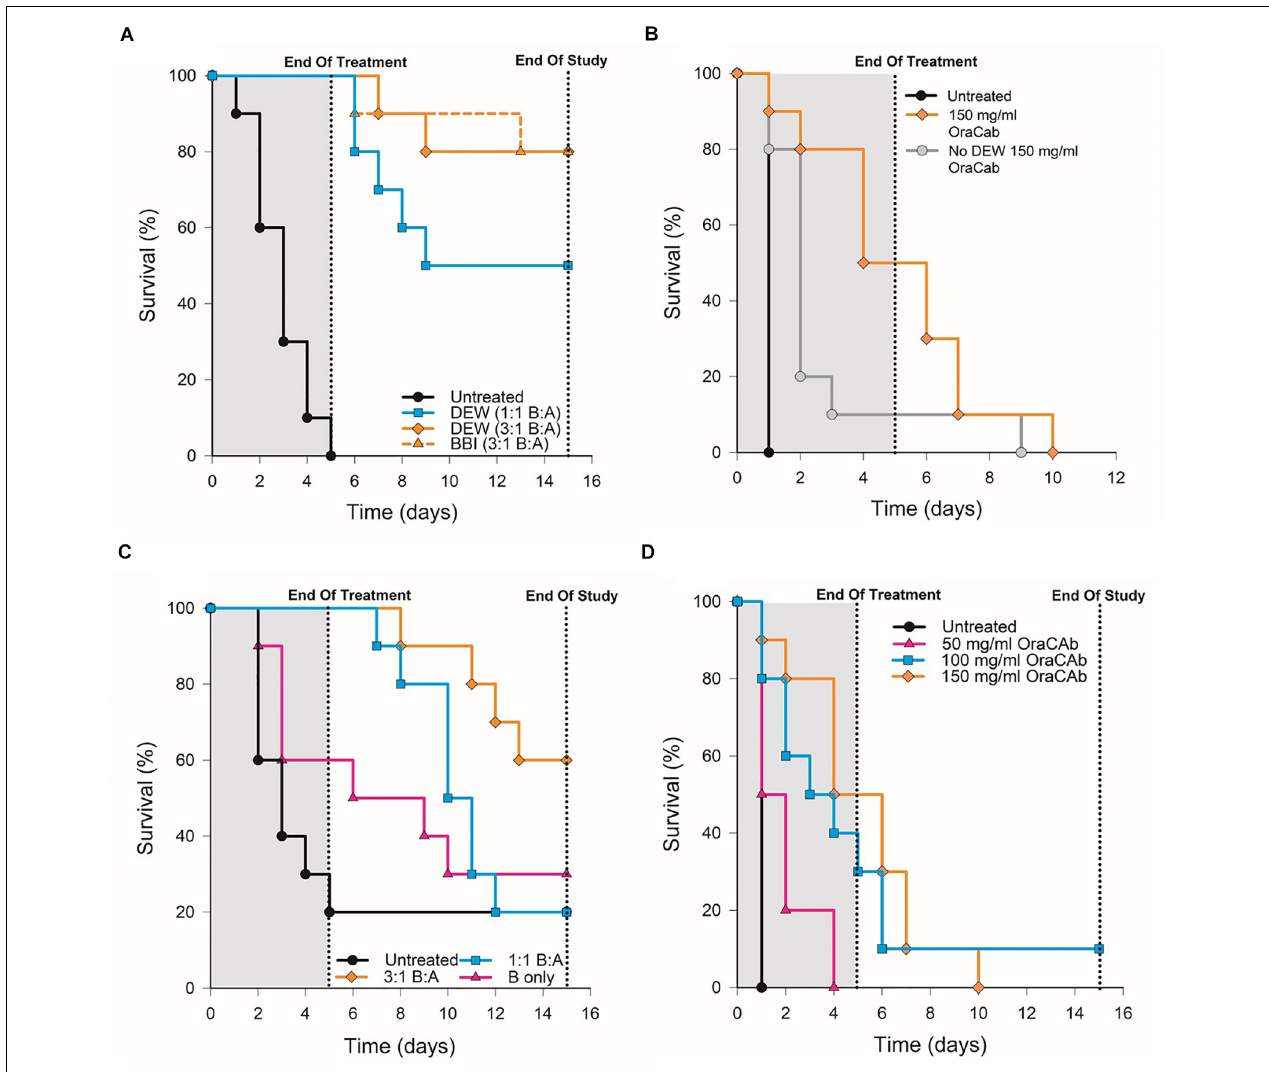
FIGURE 5 | Survival rates of hamsters after C. difficile challenge. Hamsters were challenged with C. difficile spores via the oral route on day 0, placed on one of the oral therapeutic regimes until the end of day 4 and monitored until day 15. An untreated control group, receiving challenge only, was included for each experiment. (A) Groups were treated with OraCAb containing different ratios of anti-TxB4: anti-TxA4 antibodies with either BBI or DEW as trypsin inhibitors. (B) Groups were treated using OraCAb formulated with antibody concentration of 150 mg/ml at a 3:1 anti-TxB4: anti-TxA4 ratio in the presence or absence of DEW. (C) Groups were treated with OraCAb containing different ratios of anti-TxB4: anti-TxA4 antibodies. The antibodies in OraCAb that contained anti-TxB4 IgG only were at the same concentration as anti-TxB4 antibodies in the 3:1 anti-TxB4: anti-TxA4 formulation. All OraCAb formulations contained DEW. (D) Groups were treated with OraCAb containing DEW and three different antibody concentrations (50, 100, or 150 mg/ml) at a fixed 3:1 anti-TxB4: anti-TxA4 ratio. The table shows the outcome of the statistical analyses of the